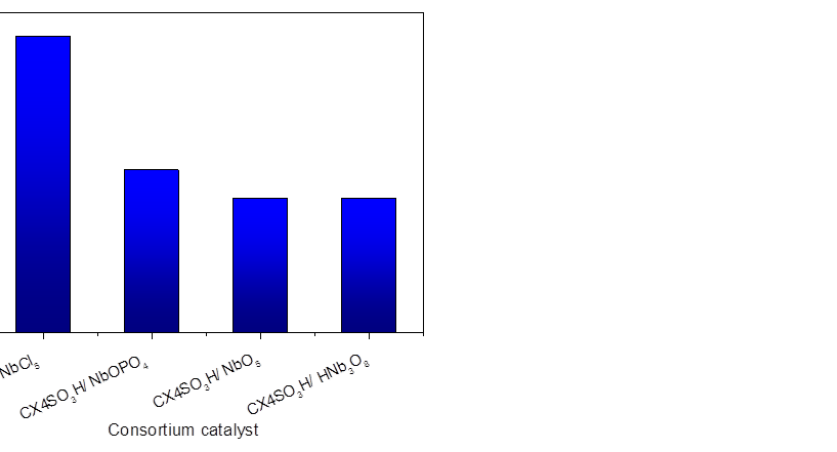
Figure 1. Comparison of different Lewis acids (niobium) fixed holding of CX4SO 3 H Brønsted acid catalysts.